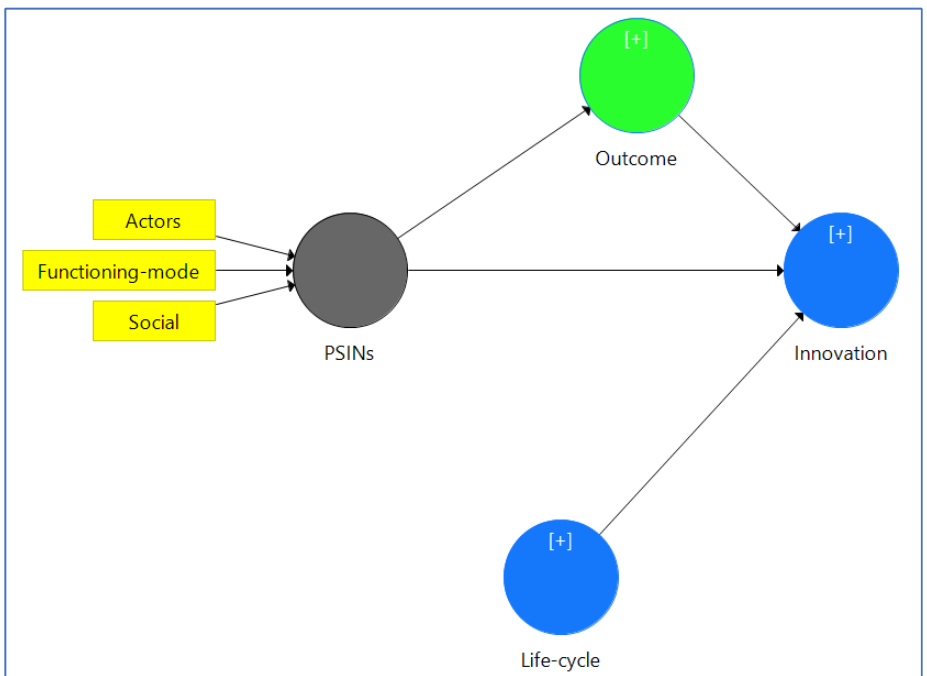
Figure 5. PSINs as a third-order component.